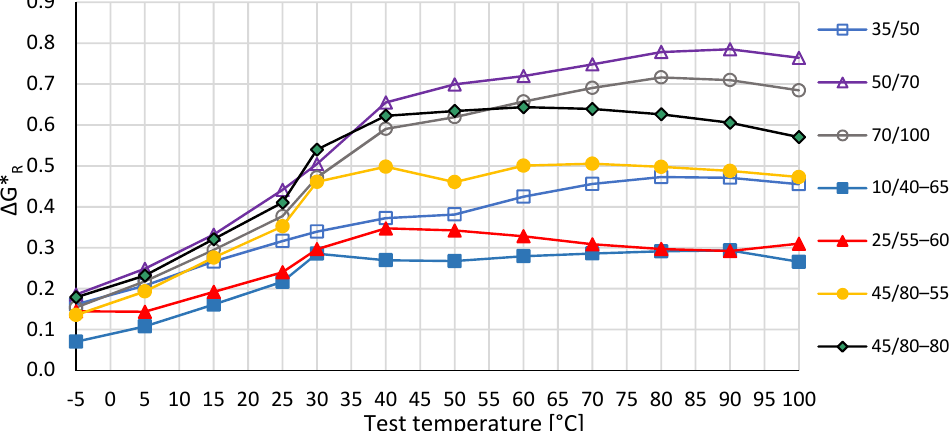
Figure 4. Δ G* R index as a function of temperature, data named in accordance with the fresh binder used as outer layer.